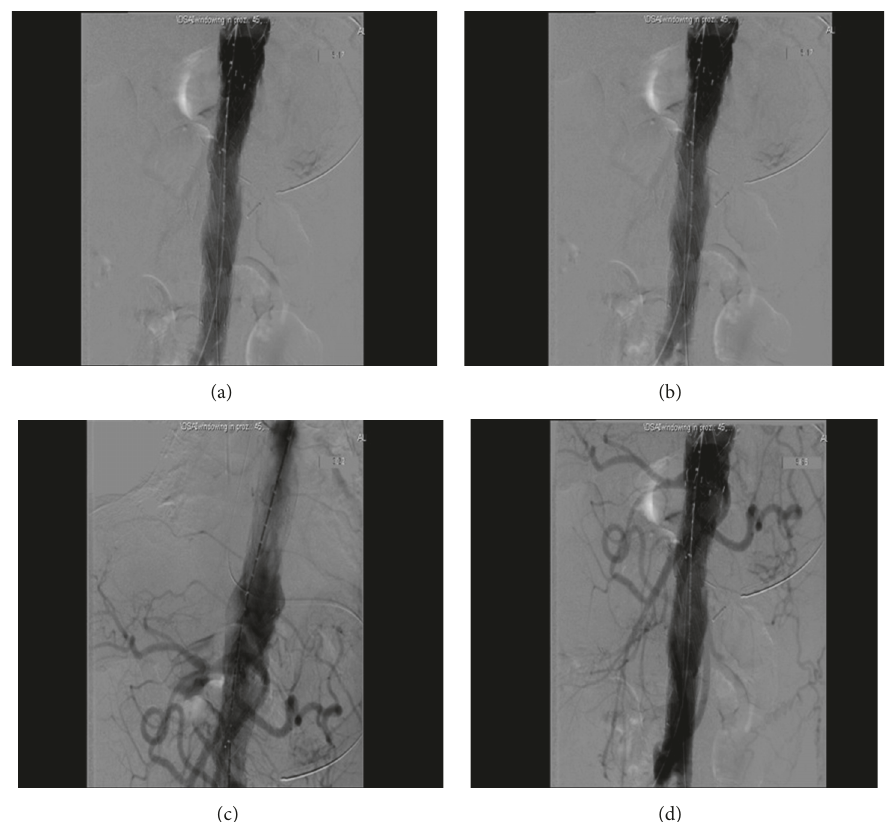
Figure 3: Intraoperative angiogram showing the reestablishment of the aortic blood flow through the stent graft with complete exclusion of the aneurysm (a, b, c, and d).